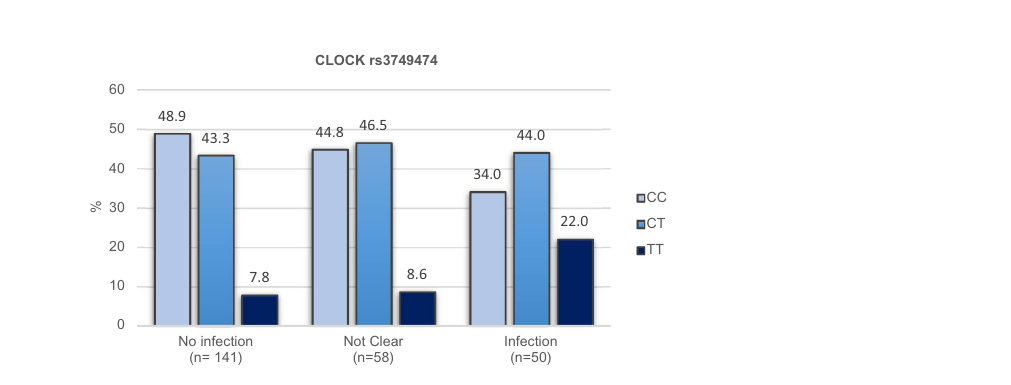
Figure 3. Percentage of the population classified according to SARS-CoV-2 infection status and the CLOCK rs3749474 genotype in additive